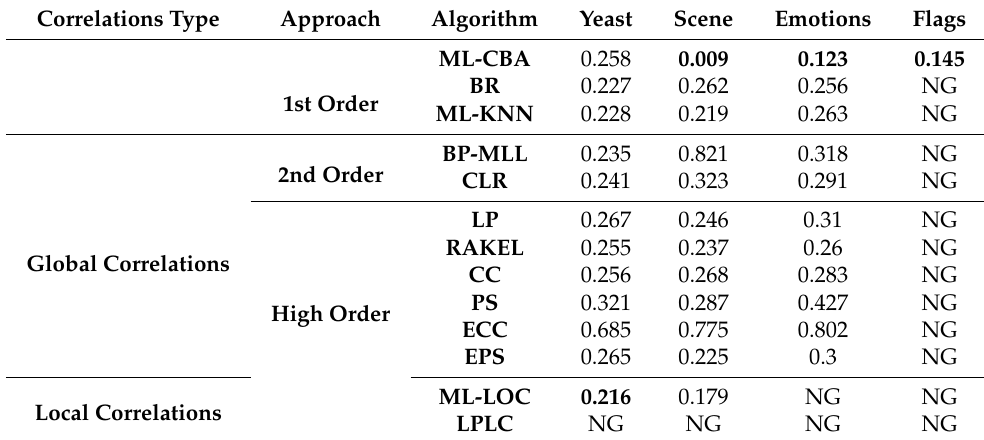
Table 5. The one-error results of the proposed ML-CBA algorithm on the regular-sized datasets with respect to several other MLC